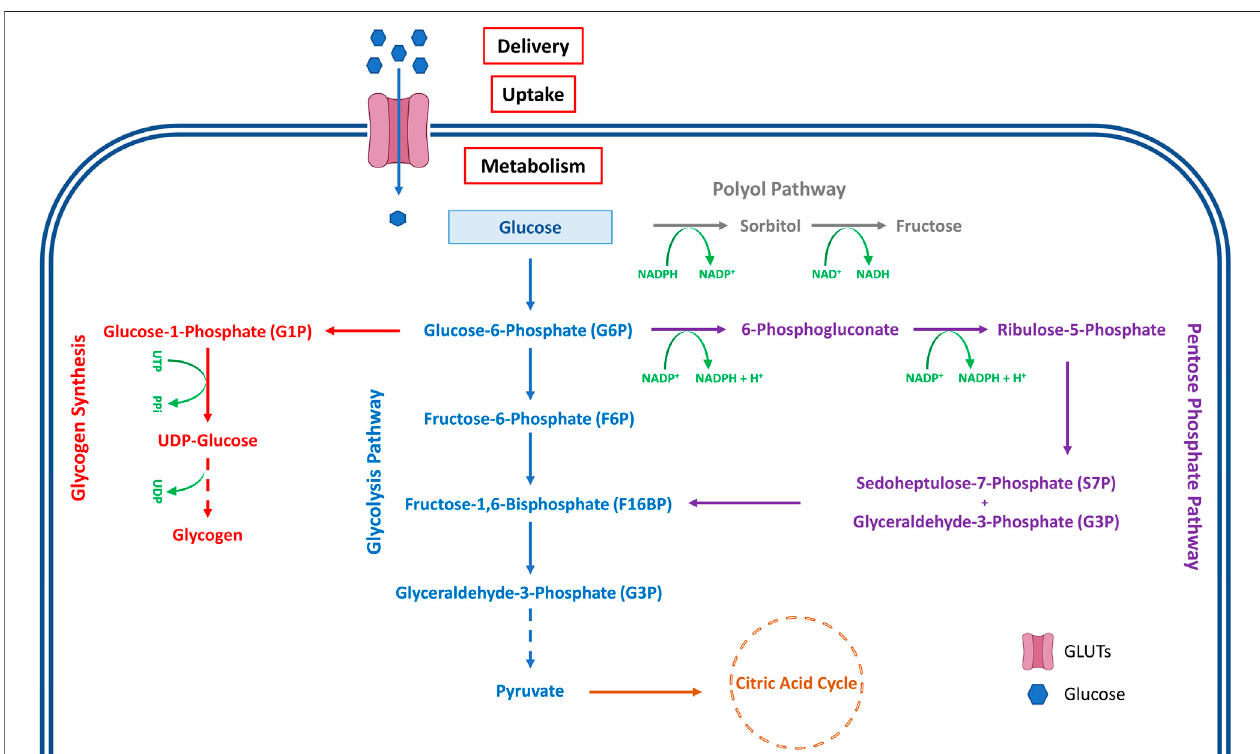
FIGURE 1 | Major pathways of glucose metabolism in the